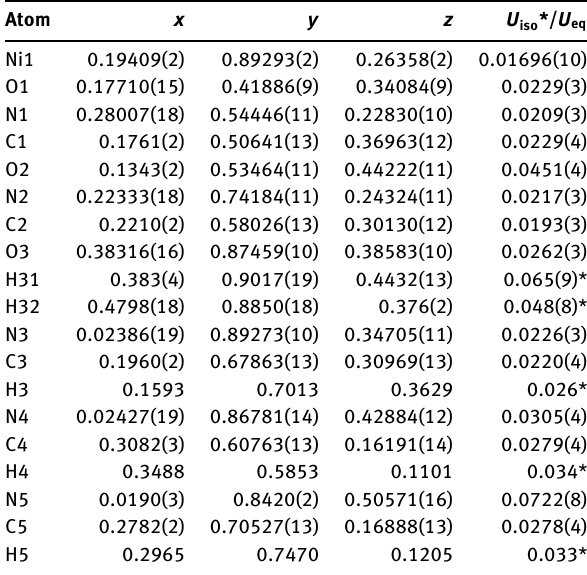
Table 2: Fractional atomic coordinates and isotropic or equivalent isotropic displacement parameters (Å 2